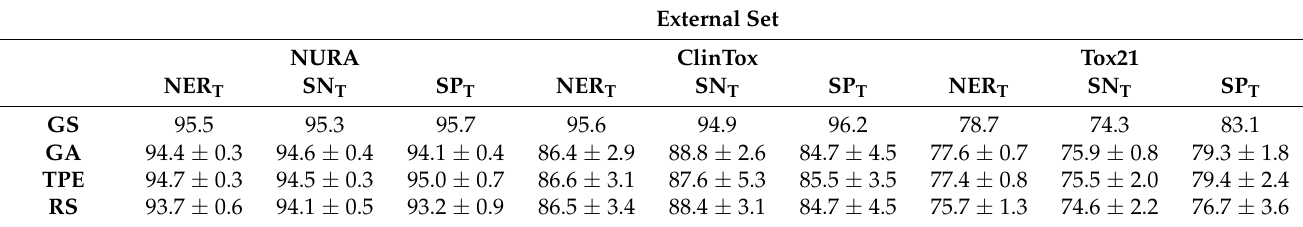
Table 2. Results in terms of overall non-error rate (NER T ), sensitivity (SN T ), and specificity (SP T ) considering grid search (GS), genetic algorithms (GA), random search (RS), and tree-structured Parzen estimator (TPE) as optimization strategies on the external test set. Confidence intervals among 10 replicas are reported for the GA and RS results.